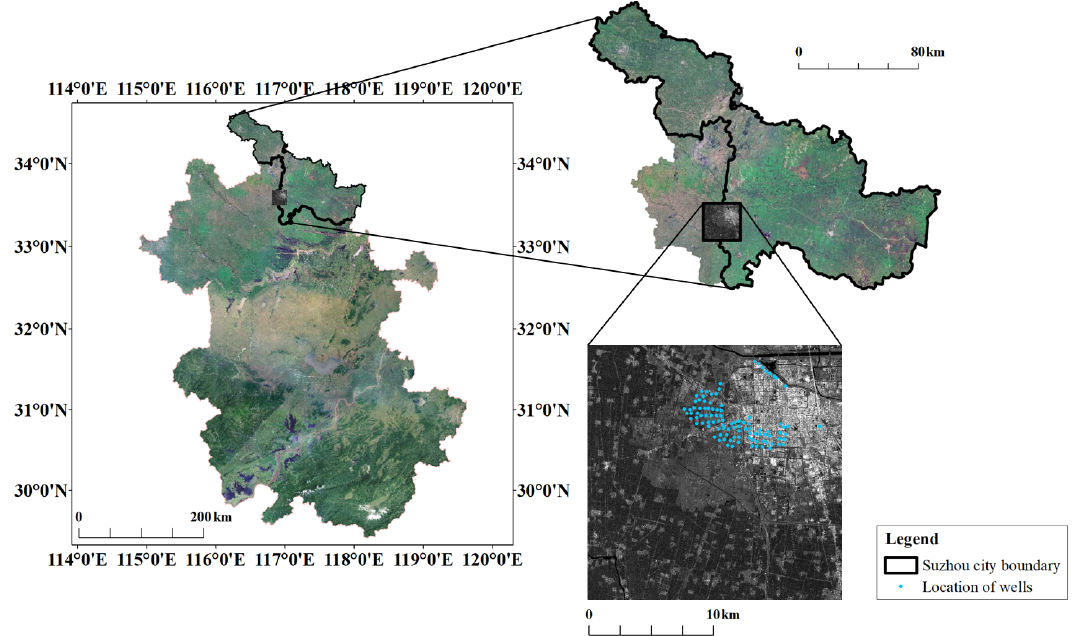
Figure 2. Location of the study area in the west water resource of Suzhou. Suzhou city is bounded by the black line. The bottom right image is the temporal amplitude average of Sentinel-1A ascending images over the study